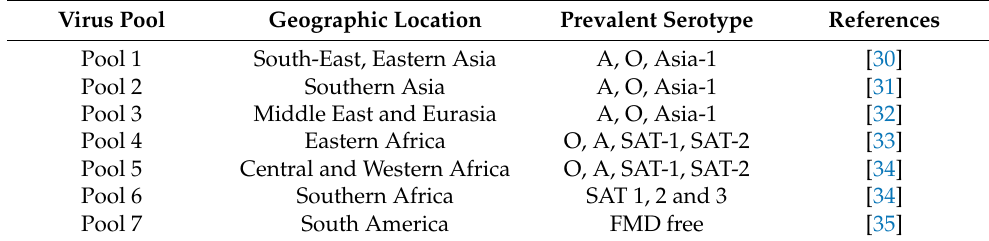
Table 1. FMDV pools with their endemic